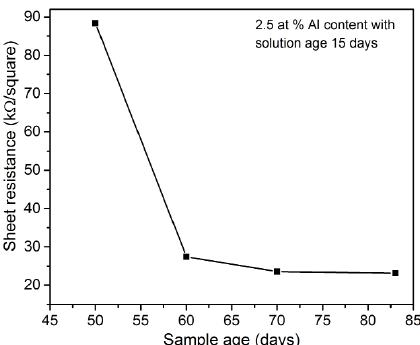
Fig. 3. Effect of sample ageing on electrical sheet resistance of ZnO : Al thin films